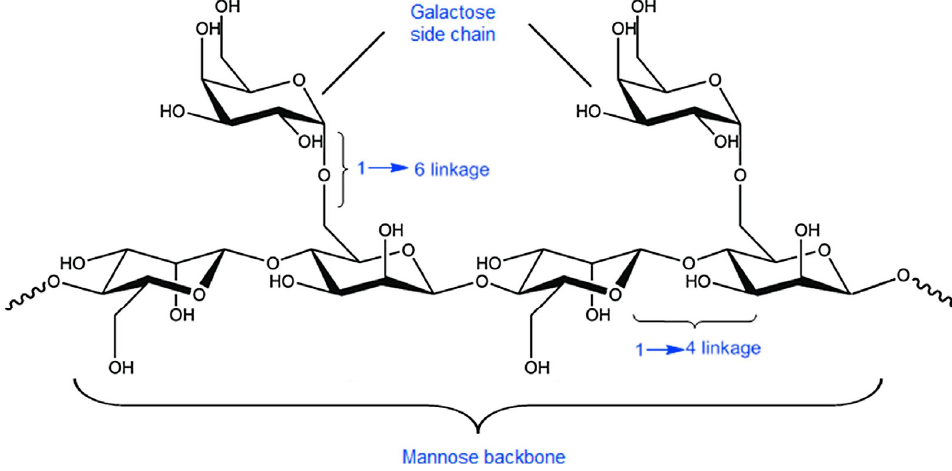
Figure 6. Typical structure of guar gum. Reproduced from [70] with permission.